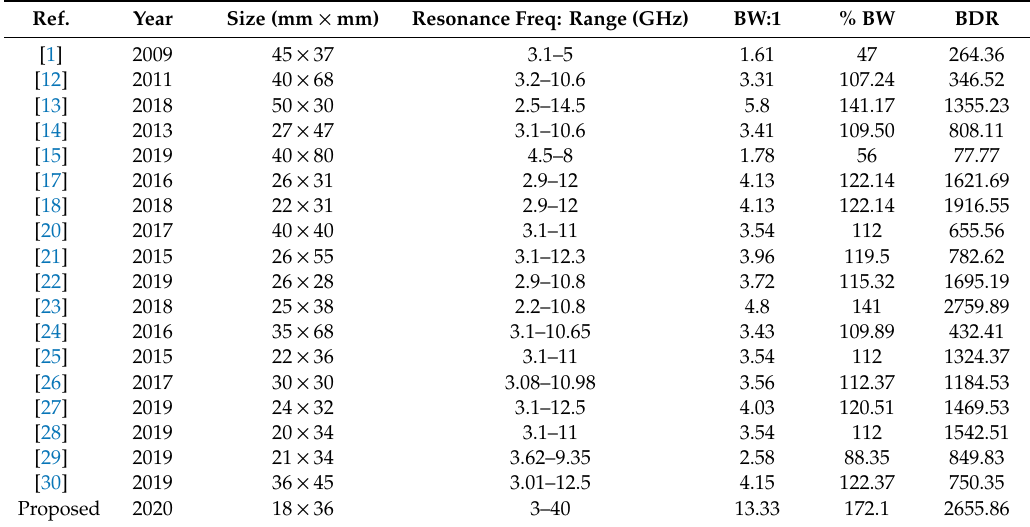
Table 1. Comparison between previously presented MIMO antennas with proposed